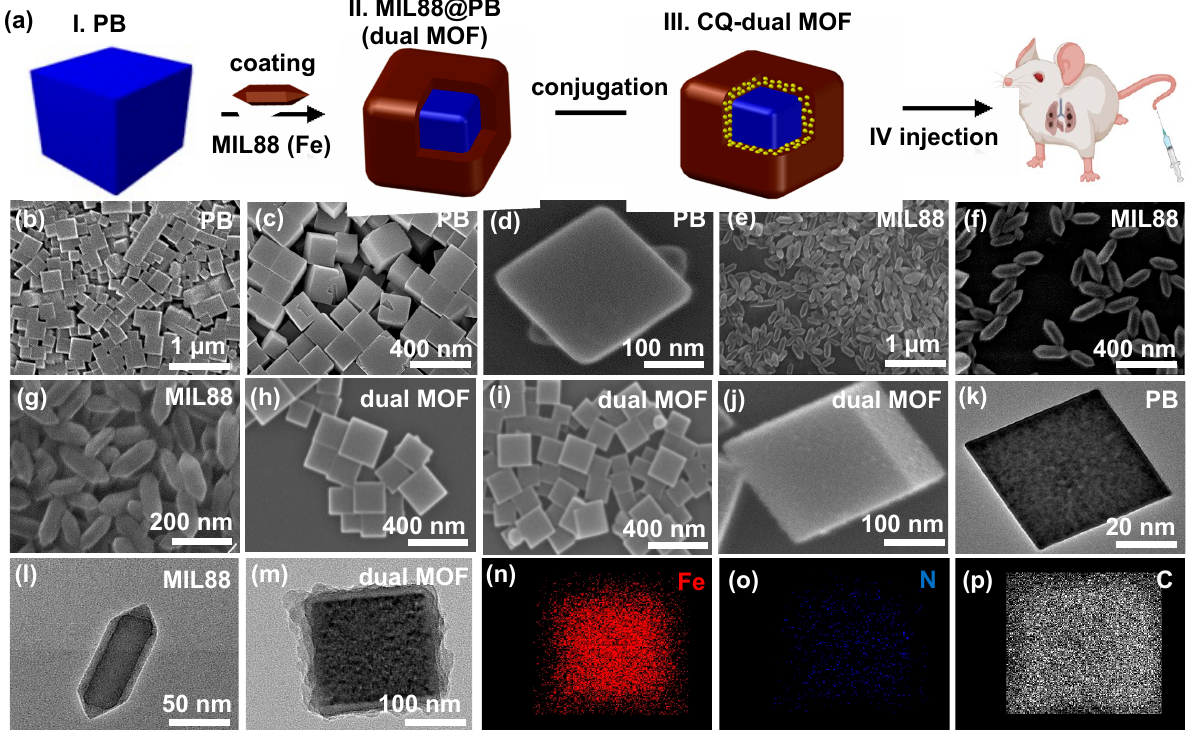
Figure 1. Synthesis and characterizations of dual MOFs. ( a ) The schematic illustration of the synthesis process of CQ-loaded dual MOF (CQ-dual MOF). The dual MOF system was reached by coating the inner Prussian blue (PB) with an outer MIL88 as a metal source and NH 2 BDC as an organic linker while. F127 pluronics and acetic acid were used for stability and tailoring the size of the MOF. ( b – i ) SEM and ( j – m ) TEM images of PB, MIL88, and dual MOFs. ( n – p ) Element mapping analysis of dual MOFs.